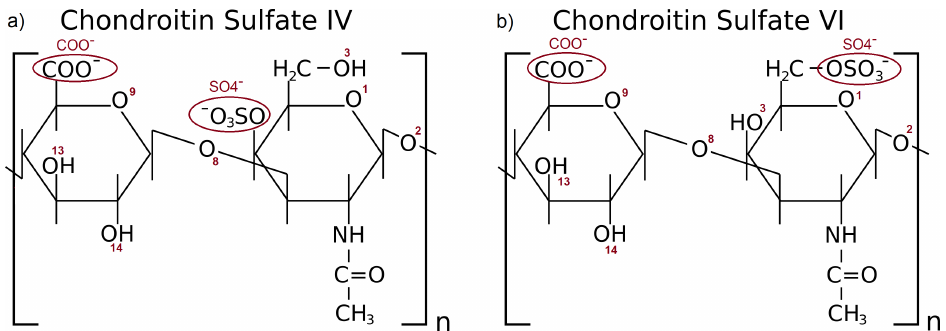
Figure 1. Schematic representation of the CS-4 ( a ) and CS-6 ( b ). The numbers of oxygen atoms and functional groups involved in forming hydrogen bonds are labeled with red